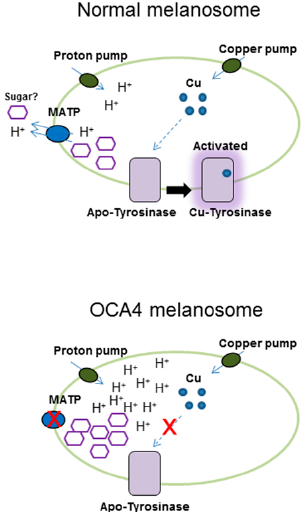
Figure 3. Membrane-associated transporter protein (MATP), a putative sucrose/H + symporter, is present in the melanosome. MATP regulates melanosomal pH for copper binding in the active site of TYR. In the oculocutaneous albinism type 4 (OCA4) melanosome, mutations in MATP cause a loss of function, and the inner melanosomal pH becomes acidic, following the loss of copper ions from the active form of TYR. As a result, melanin production is downregulated. The arrows indicate the direction of substrates such as proton and copper.